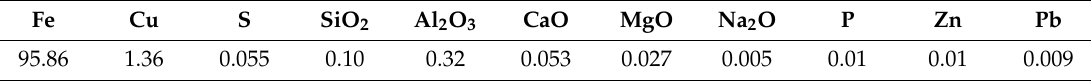
Table 4. Chemical compositions of Fe–Cu master alloy (wt %).